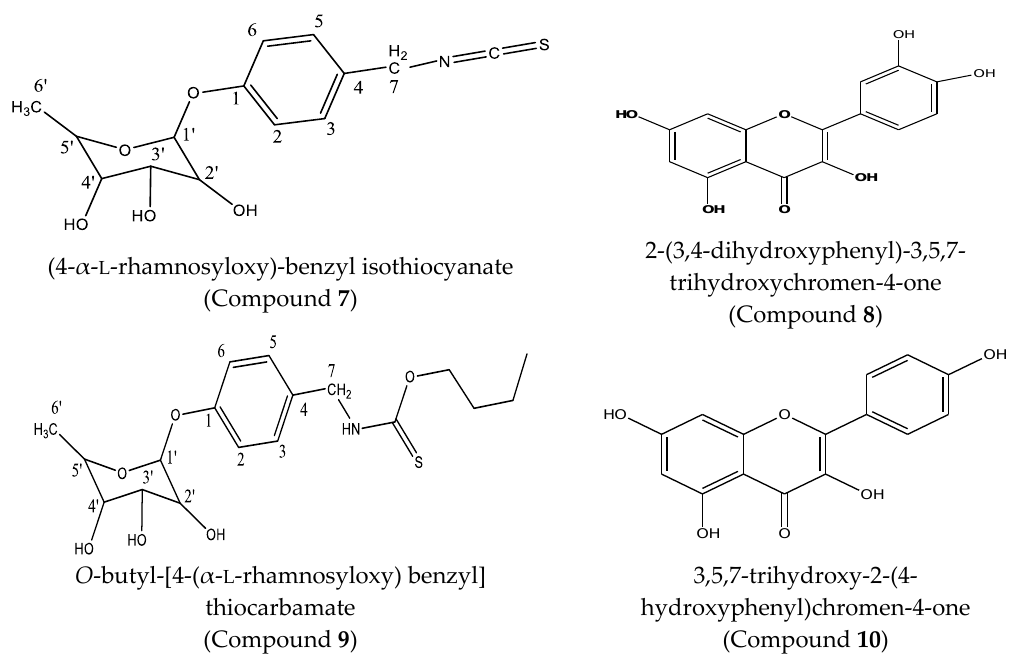
Figure 1. Structures of the analyzed compounds in Moringa oleifera Lam.